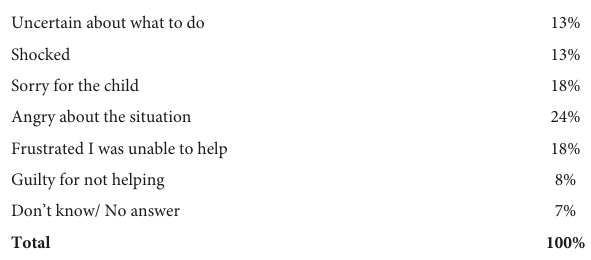
problem for the child.